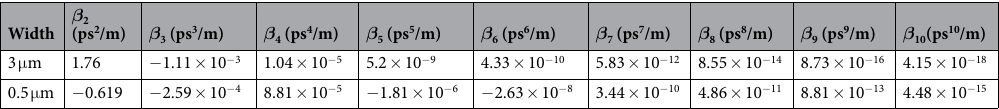
β 2 (ps 2 /m) β 3 (ps 3 /m) Width